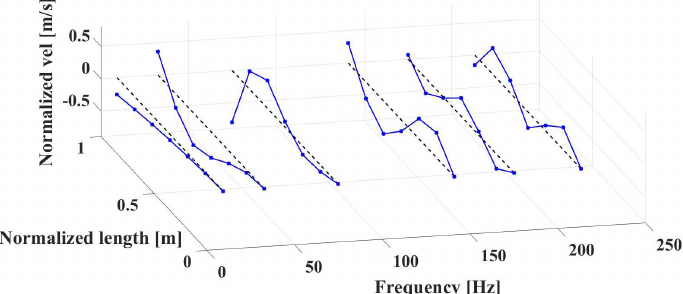
Figure 6. Graph of the six bending modes at six first resonant frequencies.